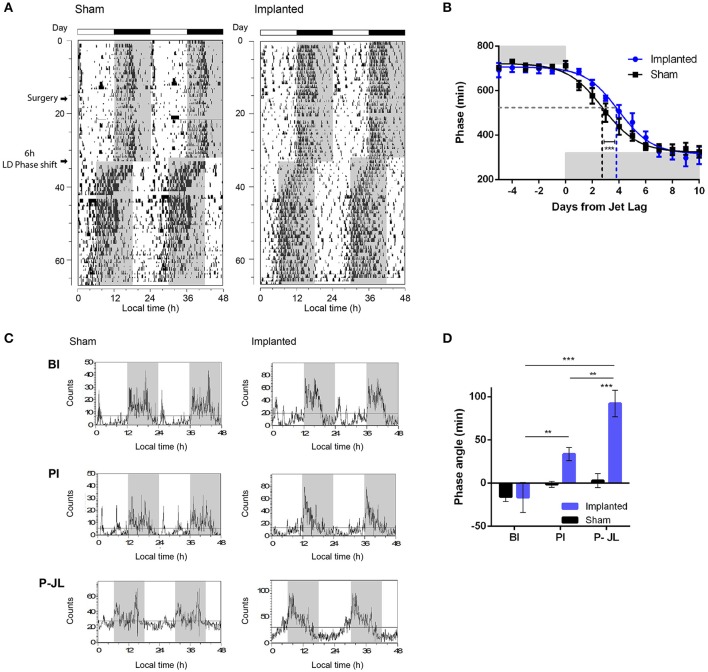
Synchronization to LD cycles is altered by hypothalamic gliomas. (A) Representative actograms of control (sham) and implanted animals under LD cycles and a simulated Jet-lag protocol (6-h advance in the LD cycle). (B) Tumor implantation resulted in slower resynchronization to abrupt shifts in the LD cycle. The phase of activity onset, in minutes, is plotted for each day before and after the Jet-lag protocol. Gray background indicates the time of lights-off. A continuous line indicates the adjusted sigmoid dose-response curve with variable slope for each group. The dashed gray line indicates the 50% phase resynchronization, and vertical dashed lines indicate the PS50 for each group. Control animals showed shorter PS50 adjusted value, indicating faster resynchronization (extra sum-of-squares F-test, ***p < 0.001, n = 6 for control and implanted animals). (C) Representative waveforms of general activity of control (sham) and implanted animals in three different stages of the protocol (BI, Before implantation; AI, After implantation; P-JL, Post Jet Lag). (D) Tumor-implanted animals exhibited an advanced phase angle between the circadian rhythm in general activity and the LD cycle. (repeated measures Two-Way ANOVA followed by Holm-Sidak's post-hoc test for stage and treatment-tumor implantation-factors, p < 0.05 for the interaction. Stage effects: **p < 0.01 for implanted animals in PI vs. BI stage, **p < 0.01 for implanted animals in P-JL vs. PI stage, and ***p < 0.001 for implanted animals in P-JL vs. BI stage, p > 0.05 for all Sham contrasts. Implantation effects: ***p < 0.001 for Sham vs. Implanted animals in the P-JL stage, p > 0.05 for all other contrasts; n = 6 for control and implanted animals).